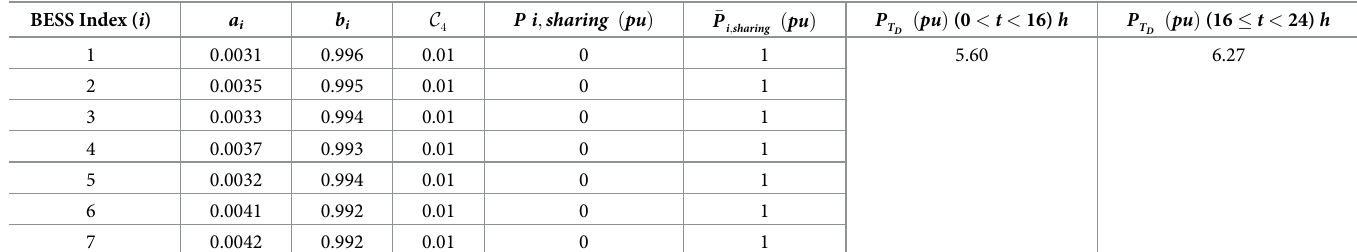
Table 3. Different parameters of the BESSs for economic load dispatch.